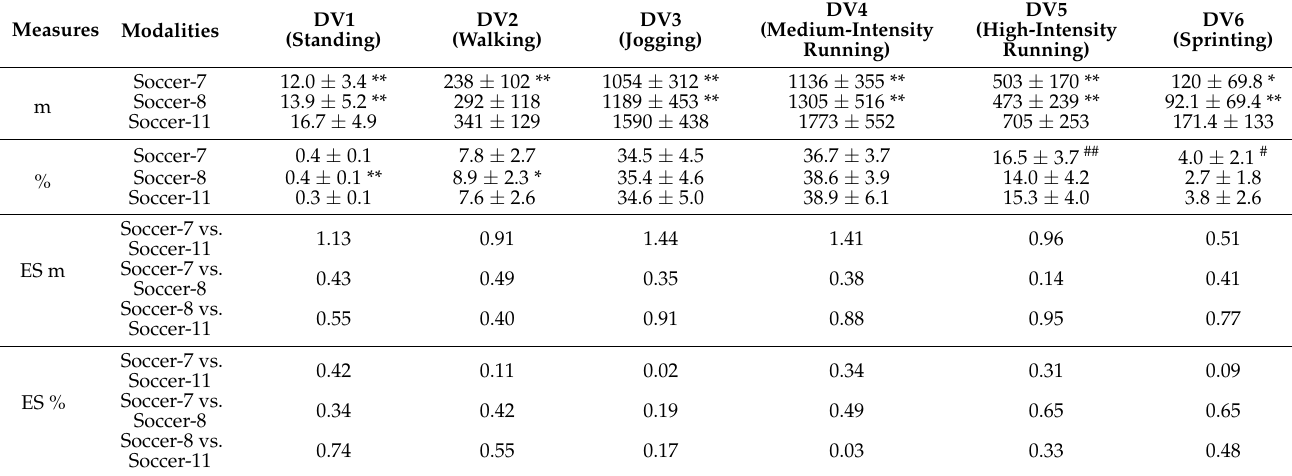
Table 1. Distance covered at different speeds during Soccer-7, Soccer-8, and Soccer-11 official matches. Measures Modalities